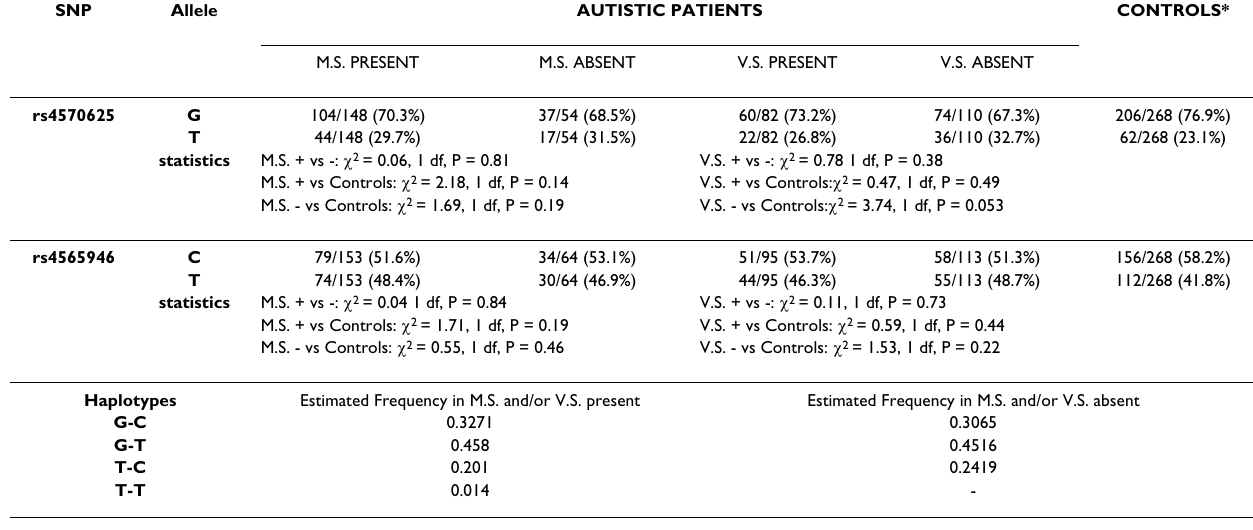
Table 4: TPH2 alleles in autistic patients with(+) or without (-) motor stereotypies (MS) or verbal stereotypies (VS). SNP Allele AUTISTIC PATIENTS